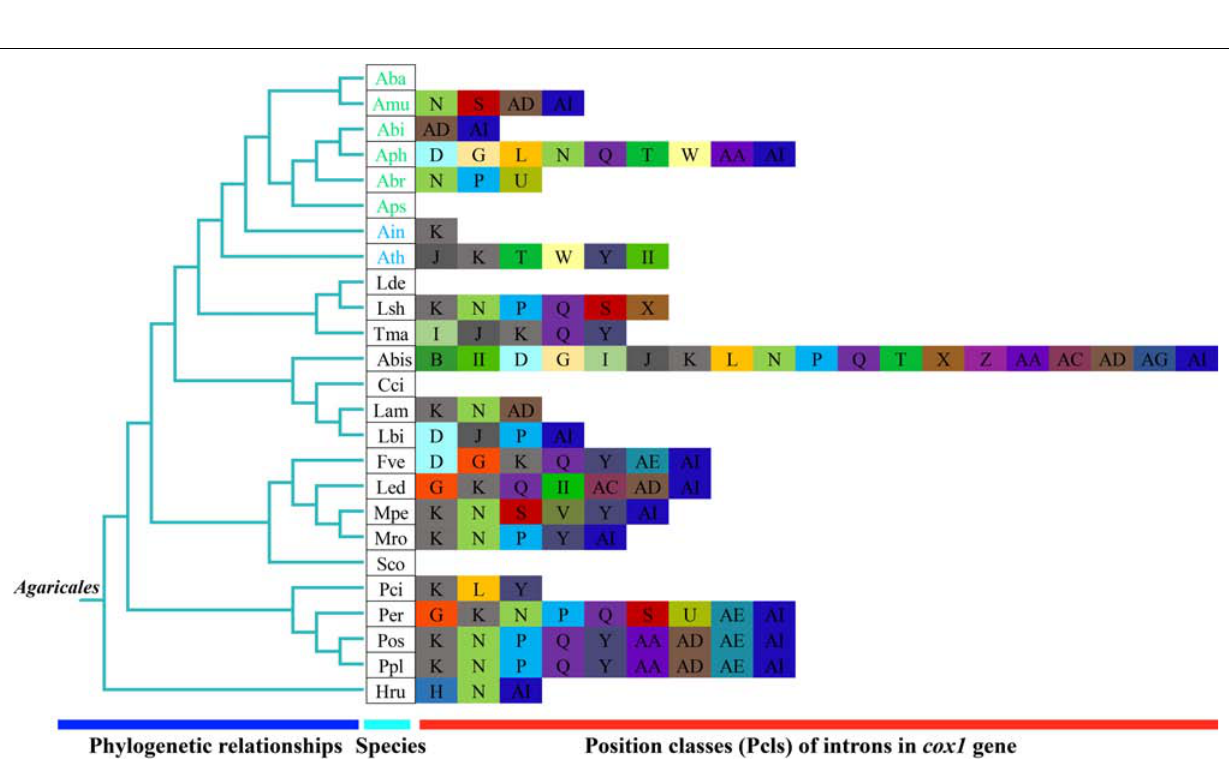
Frontiers in Microbiology |